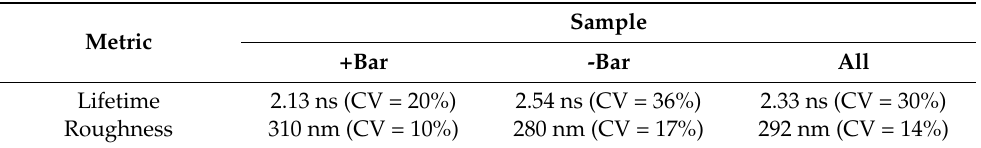
Figure 3. Lifetime and roughness behaviors of samples with and without a barrier ( a ) and samples per factor-level barrier ( b ). Table 2. Spread of data for the absorbers. The average value is followed by the coefficient of variation